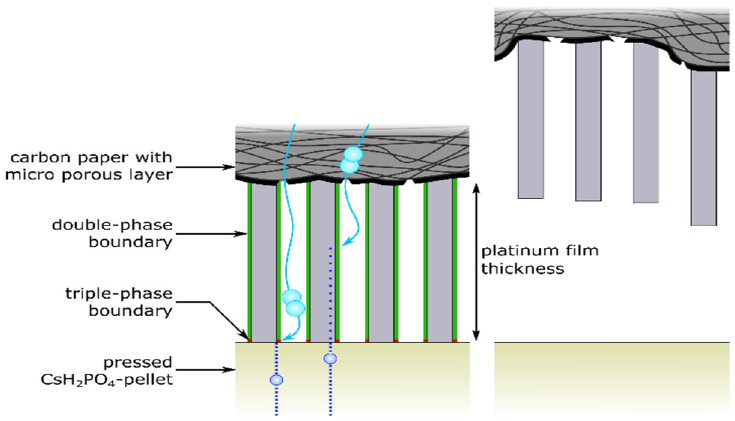
Figure 4. Cross-section through the anode of the solid acid fuel cell. The scheme shows protons (darker blue), hydrogen gas (lighter blue), the double-phase (green lines) and triple-phase boundary (red dots) on the Pt columns of the open-structured GDE. The roughness mismatch between the Pt- coated carbon paper and the electrolyte pellet is indicated by the hollow microsphere. The illustration is not to scale.